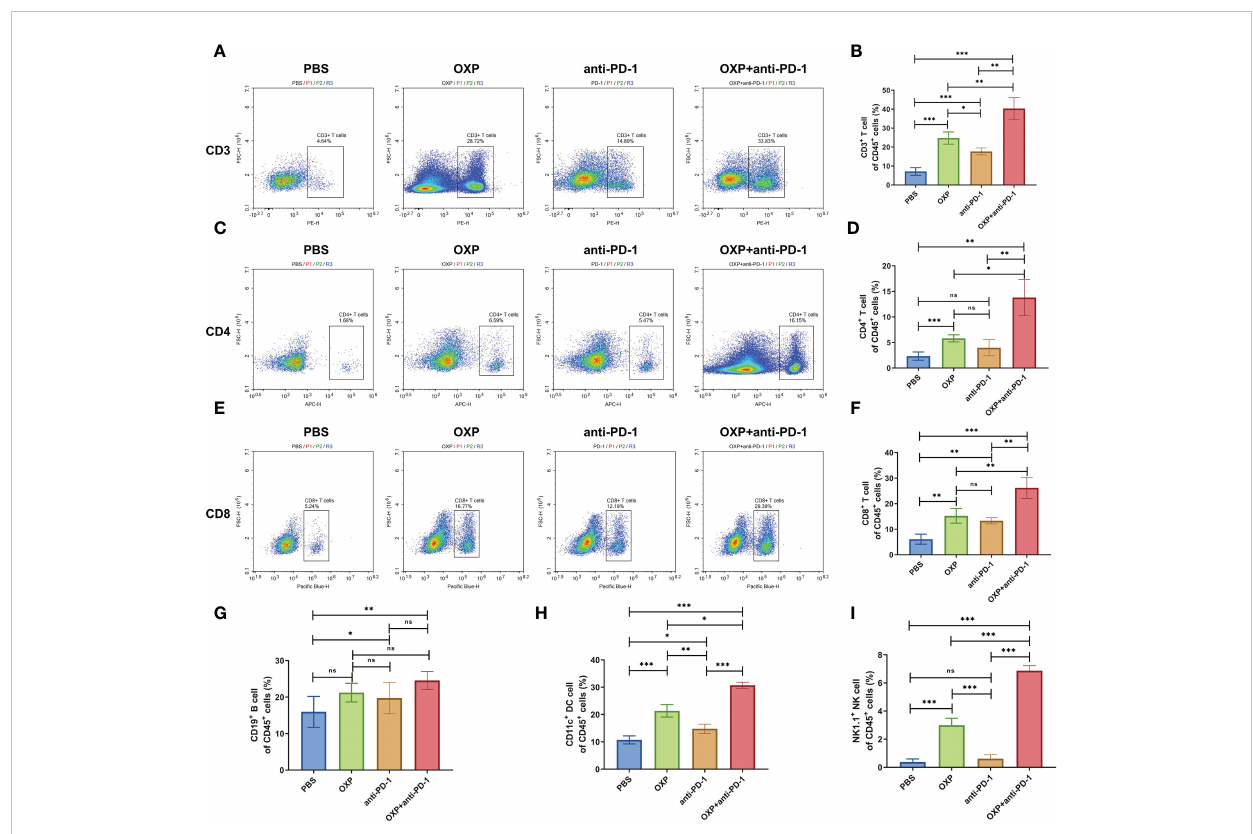
FIGURE 3 Composition of major immune cells populations in tumor immune microenvironment. (A) Representative fl ow cytometric pro fi les of CD3 + T cells. (B) The percentage of CD3 + T cells of CD45 + cells. (C) Representative fl ow cytometric pro fi les of CD4 + T cells. (D) The percentage of CD4 + T cells of CD45 + cells. (E) Representative fl ow cytometric pro fi les of CD8 + T cells. (F) The percentage of CD8+ T cells of CD45 + cells. (G) The percentage of CD19 + B cells of CD45 + cells. (H) The percentage of CD11c + DC cells of CD45 + cells. (I) The percentage of NK1.1 + NK cells of CD45 + cells. ns P >